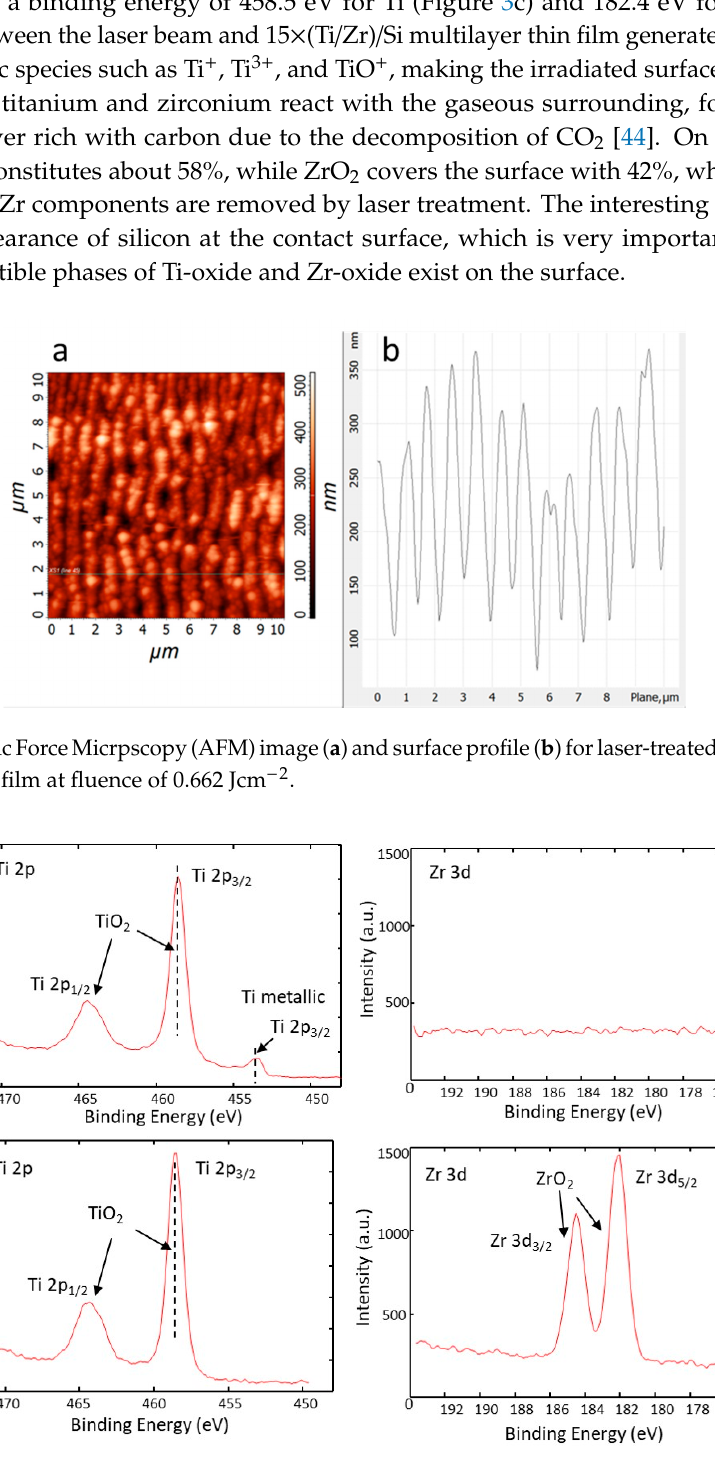
Figure 3. XPS spectra of ( a ) Ti 2p and ( b ) Zr 3d for the surface of as-deposited 15 × (Ti / Zr) / Si multilayer thin films and XPS spectra ( c ) Ti 2p and ( d ) Zr 3d recorded after laser